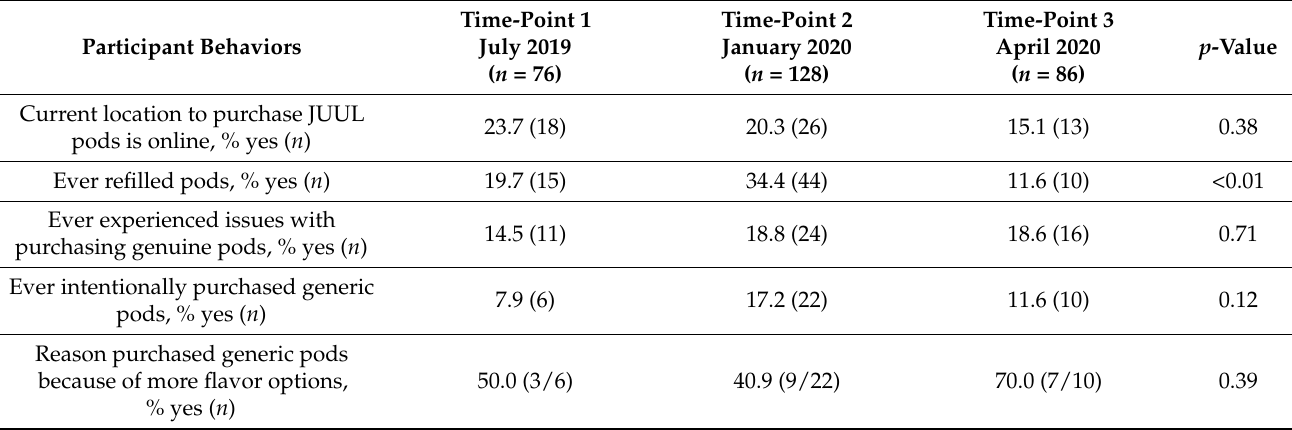
Table 2. Participant behaviors by survey